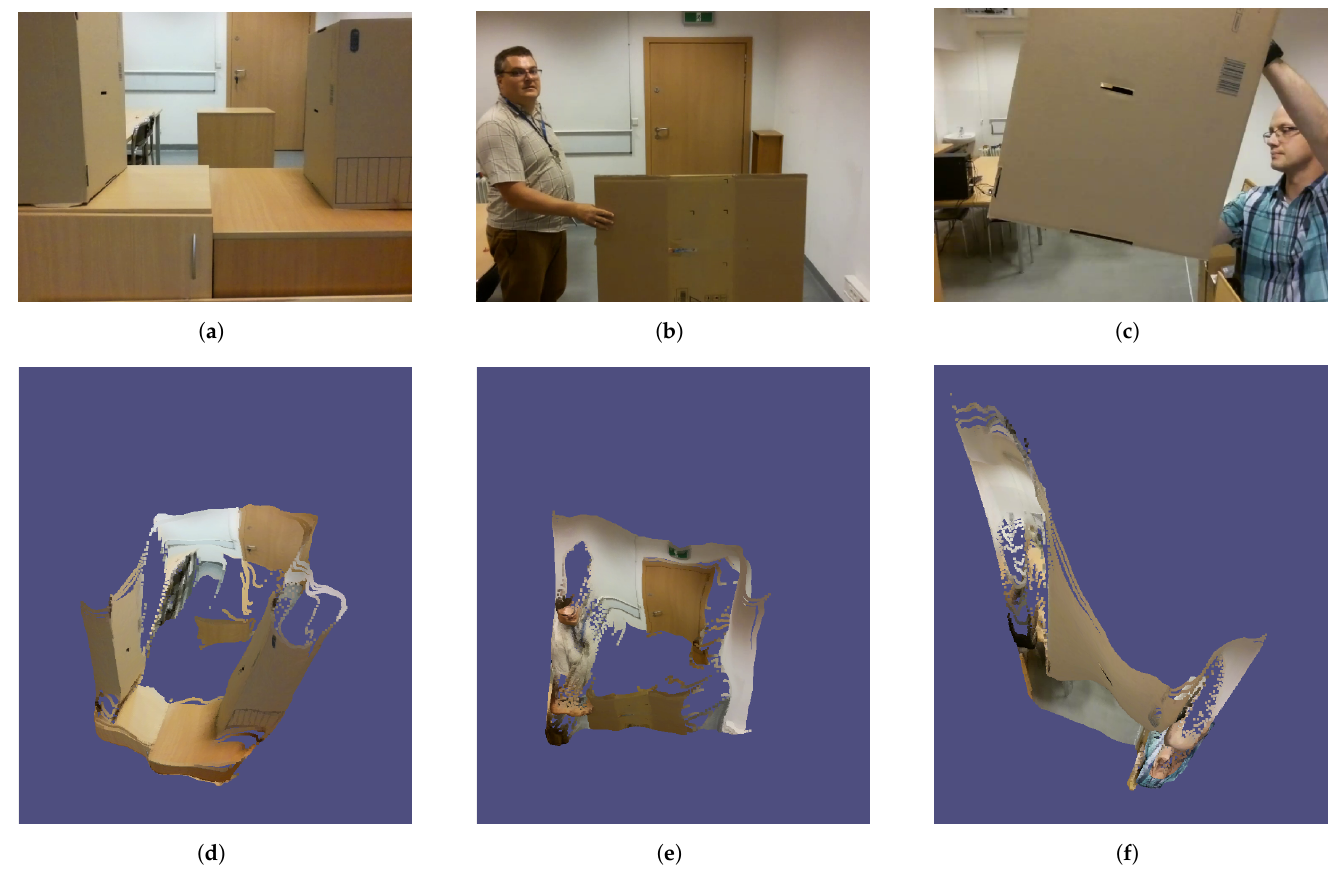
Figure 2. Examples of distance estimation inaccuracies visualized with point clouds. Top row ( a – c ) contains RGB image; bottom row contains depth estimation ( d – f